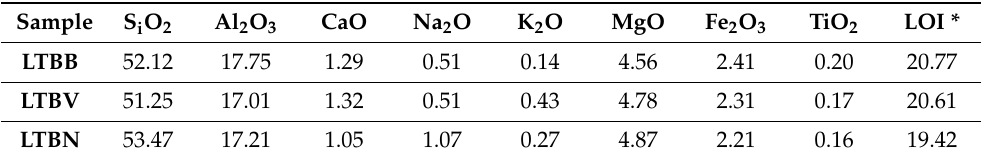
Table 2. Chemical composition (wt% oxides) of bentonites from the Los Trancos deposit, by Garc í a- Romero et al.